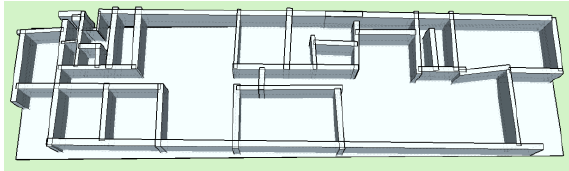
Figure 4: Walls and floor obtained after the reconstruction of the Fire brigade building using point clouds. This is an intermediate result which after the space subdivision generates correct spaces.